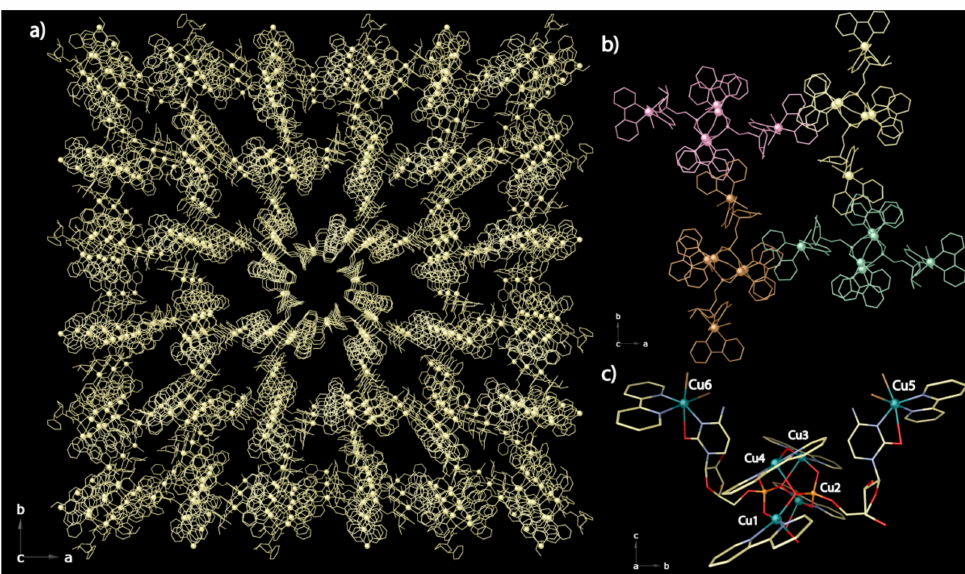
Figure 1. Crystal structure of CMP MOF 1 : ( a ) perspective view of the 3D supramolecular porous network along the c crystallographic axis; ( b ) unit cell content representing four hexameric [Cu 6 (bipy) 6 (CMP) 2 ( µ -O)Br 4 ] 2+ entities, packed via 2+ hexameric unit. Color scheme: ( a ) phosphorous, π ··· π interactions; ( c ) perspective view of [Cu µ -O)Br 6 (bipy) 6 (CMP) 2 ( 4 ] oxygen, nitrogen, carbon, and bromide are represented as gold sticks whereas copper as gold spheres; ( b ) green, gold, pink and brown colors are used to underline the four enlaced hexameric units; ( c ) copper, cyan spheres; phosphorous, orange; oxygen, red; nitrogen, blue; carbon, grey; bromide, brown. Hydrogen atoms and lattice water molecules have been omitted for the sake of